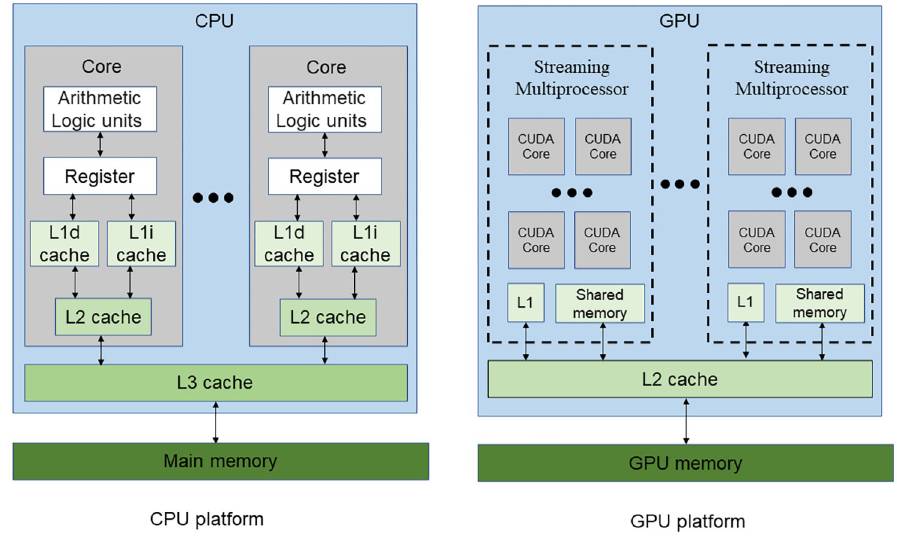
Fig 4. Architecture of the CPU and GPU computing